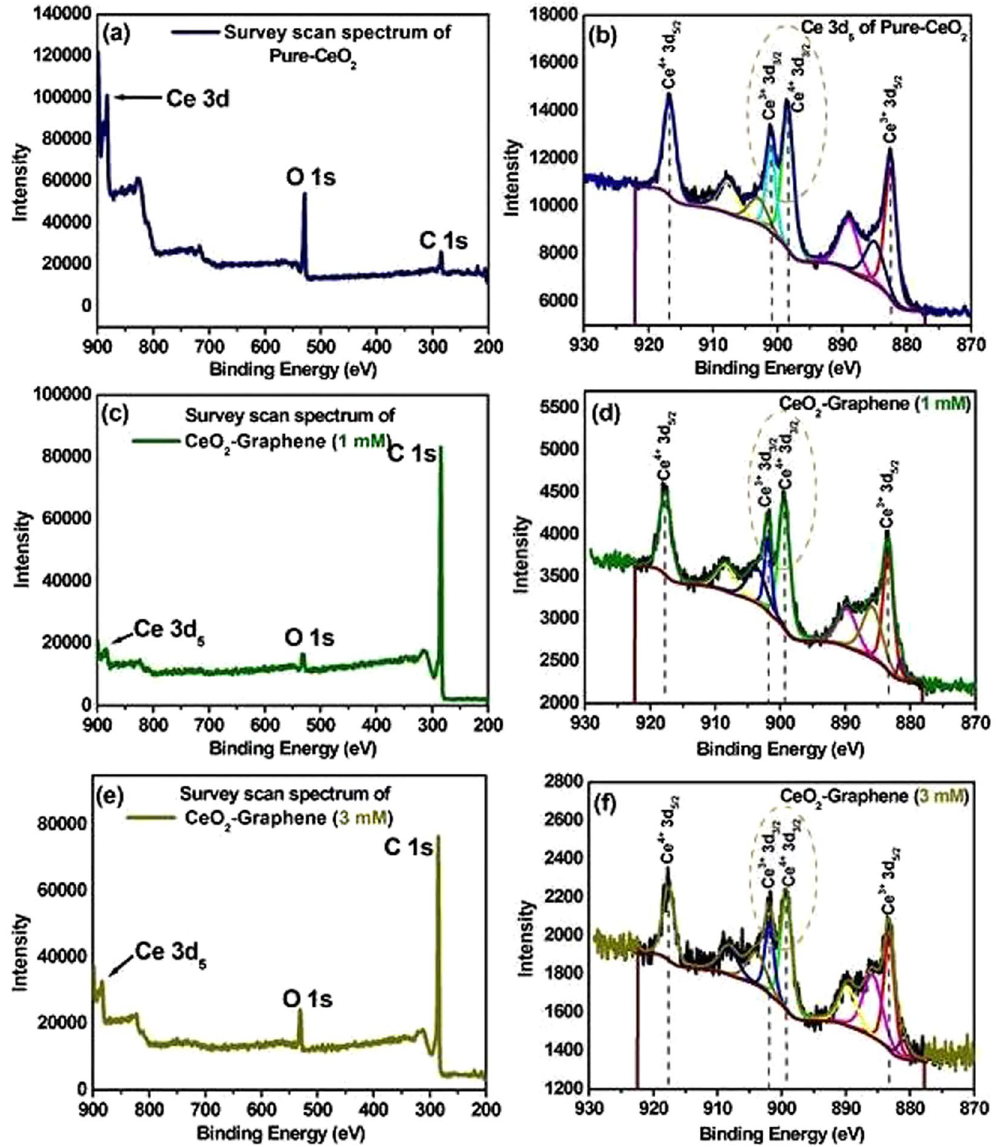
Figure 5. ( a , c and e ) Survey scan spectra and deconvoluted XPS region spectra ( b , d and f ) of Ce 3d fitted spectra of pure-CeO 2 NPs, 1 mM, and 3 mM CeO 2 -Graphene